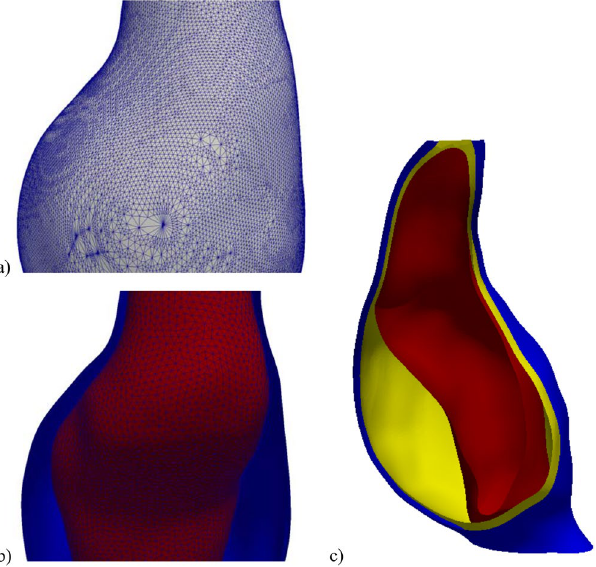
Figure 12. Example of geometry creation. ( a ) Geometry extracted from label map. ( b ) Re-meshed geometry. ( c ) Final geometry (AAA exterior surface in blue, interior surface in yellow and ILT surface in